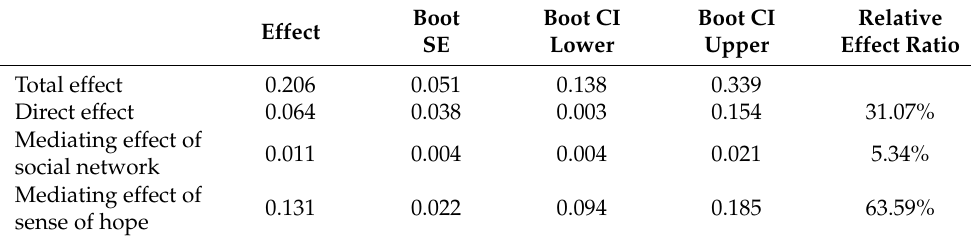
Table 5. Total effect, direct effect and mediating